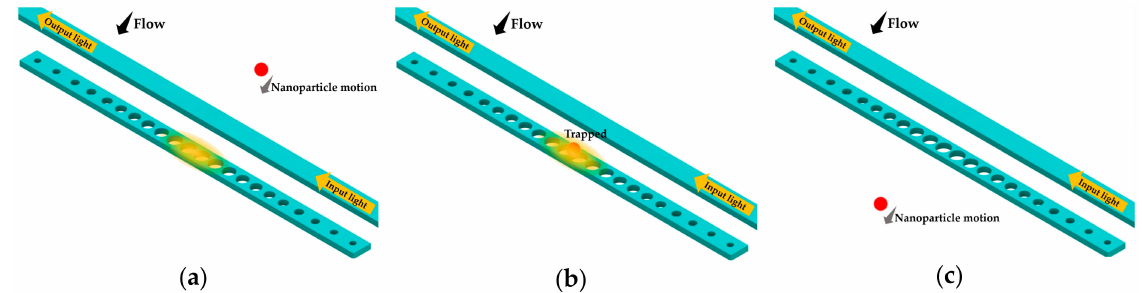
Figure 13. Schematics of the trap and release for nanoparticle in time sequence: ( a ) nanoparticle in flowing sample with laser power on; ( b ) nanoparticle trapped in the area where the optical field is the strongest; ( c ) nanoparticle released after laser power